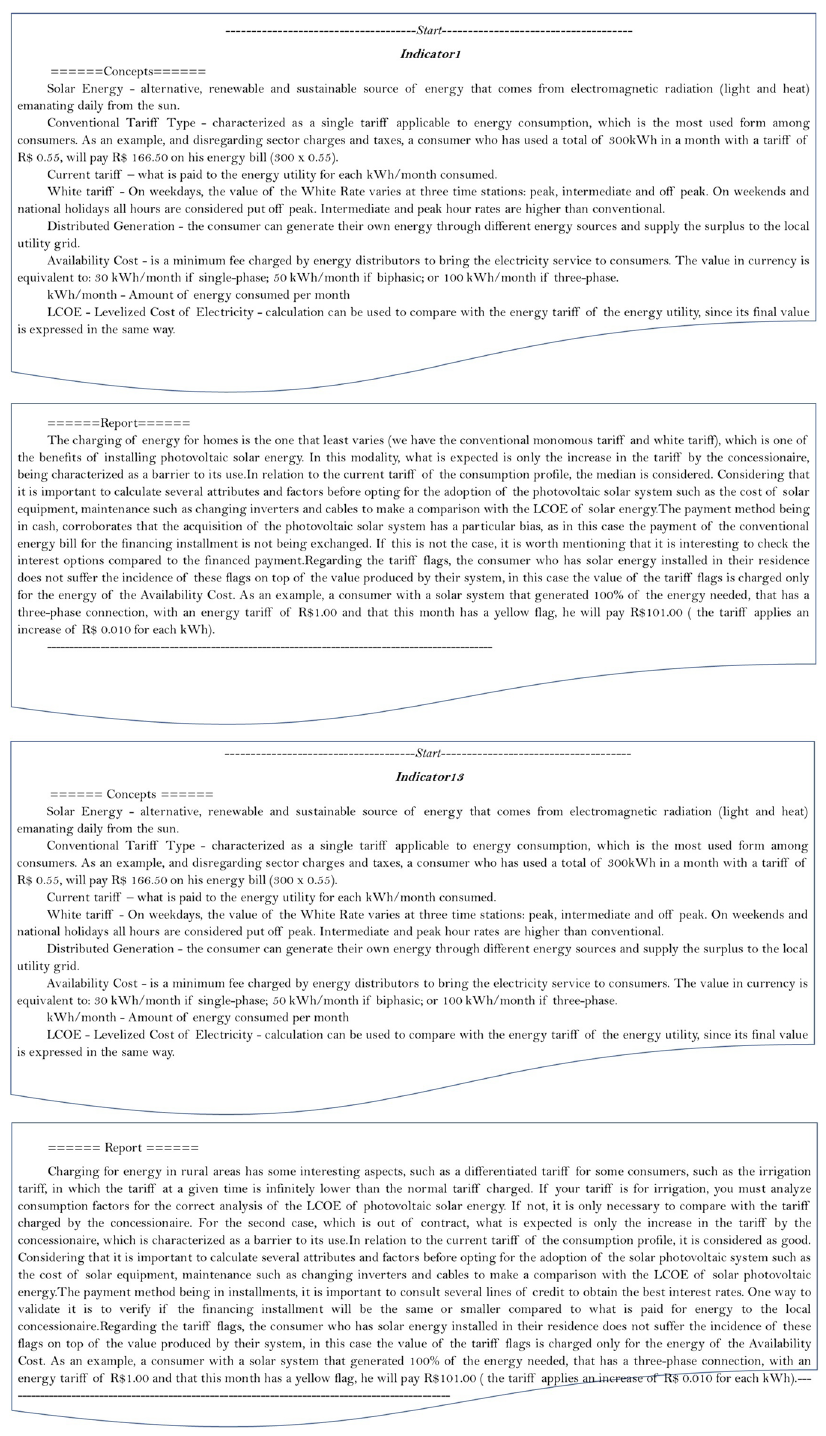
Fig. 12 Description of indicators 1 and